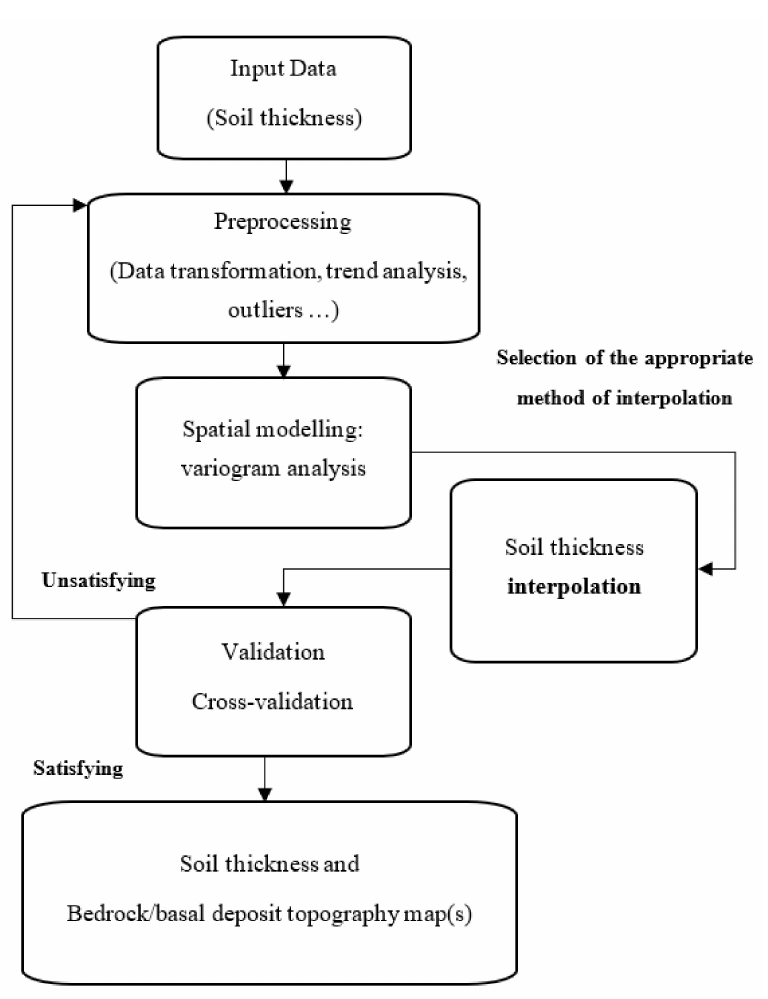
Figure 3. Phase II: workflow of the spatial interpolation of total soil thickness and thickness of the continuous basal